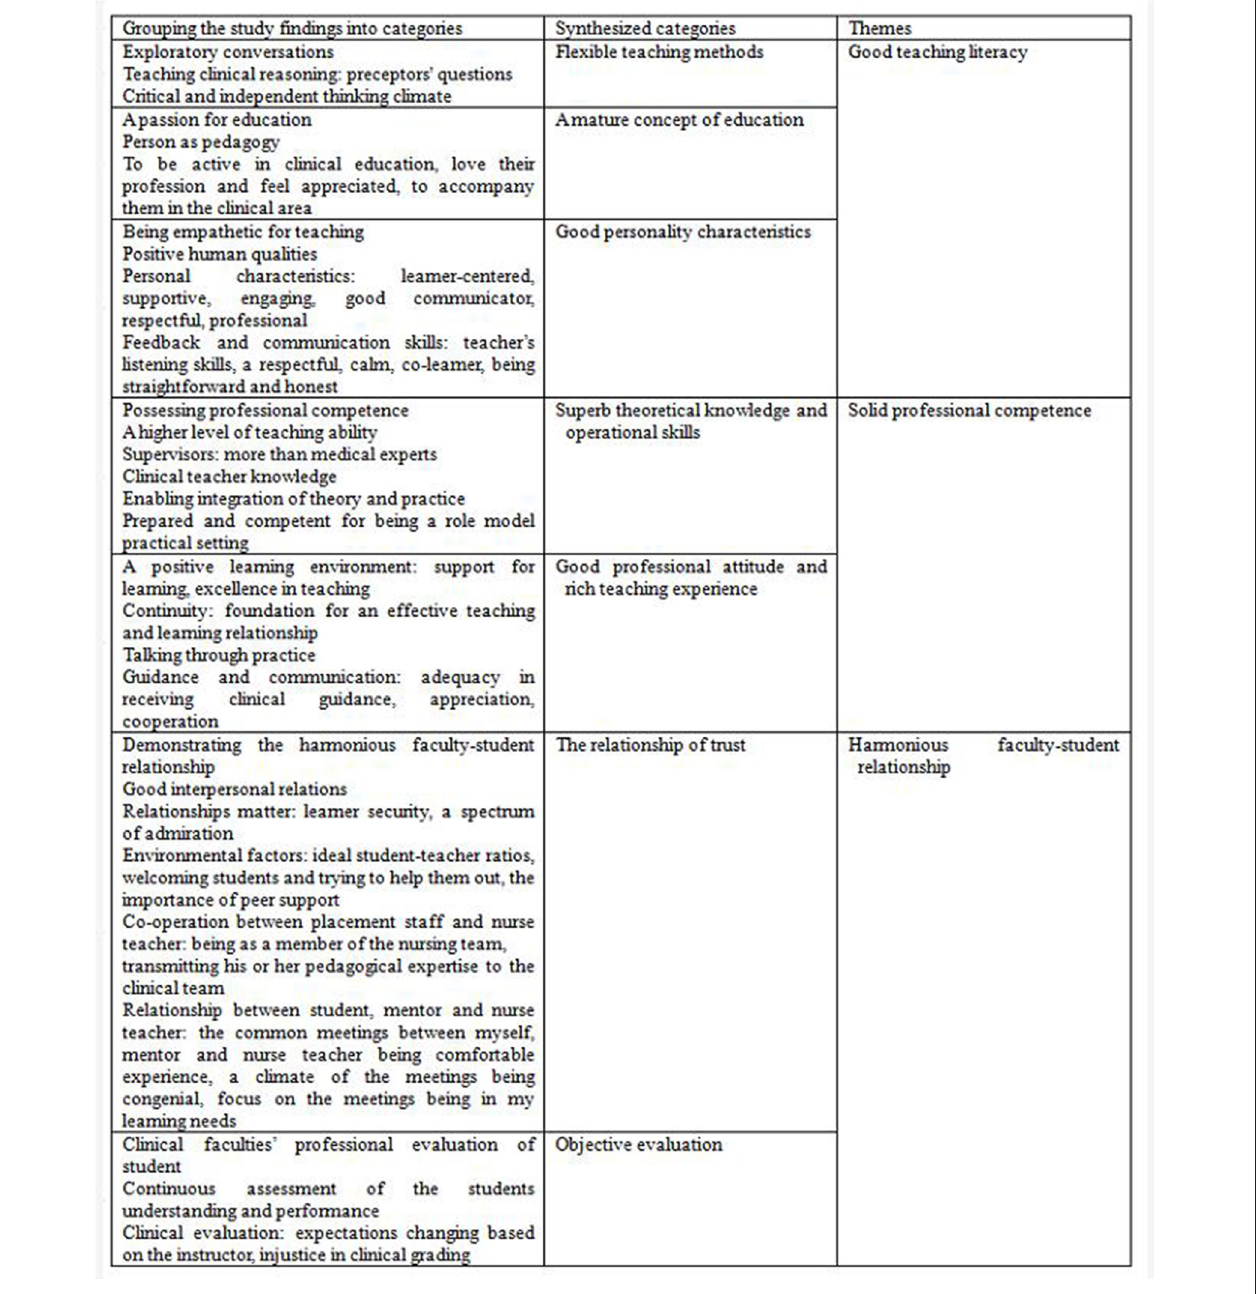
further the development of students’ ability. One